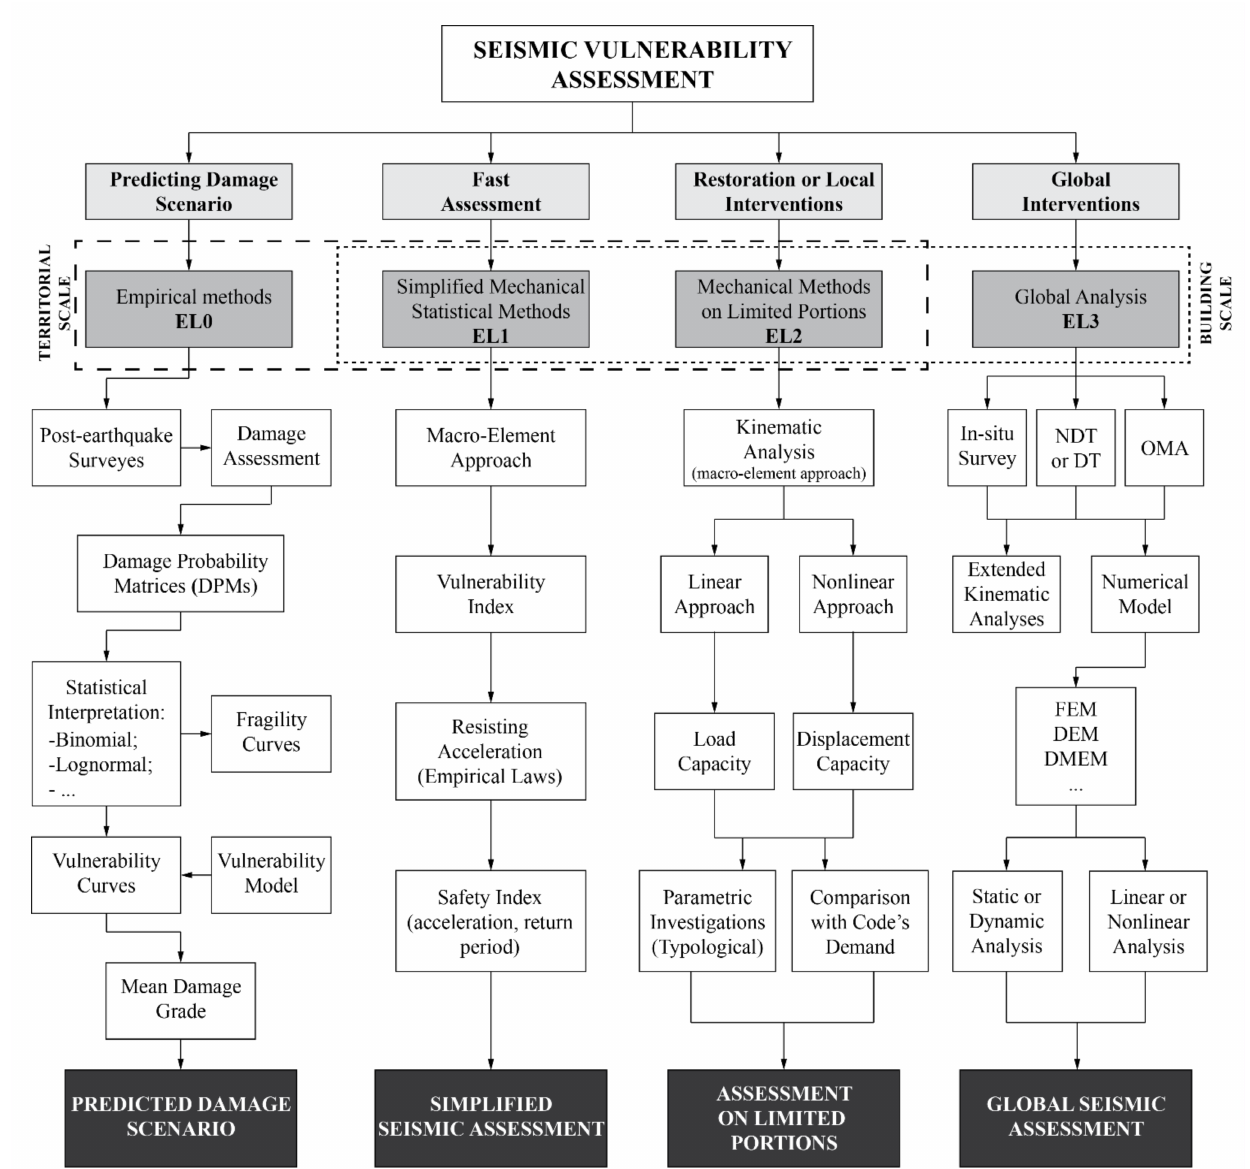
Figure 1. Components of seismic vulnerability assessment at different